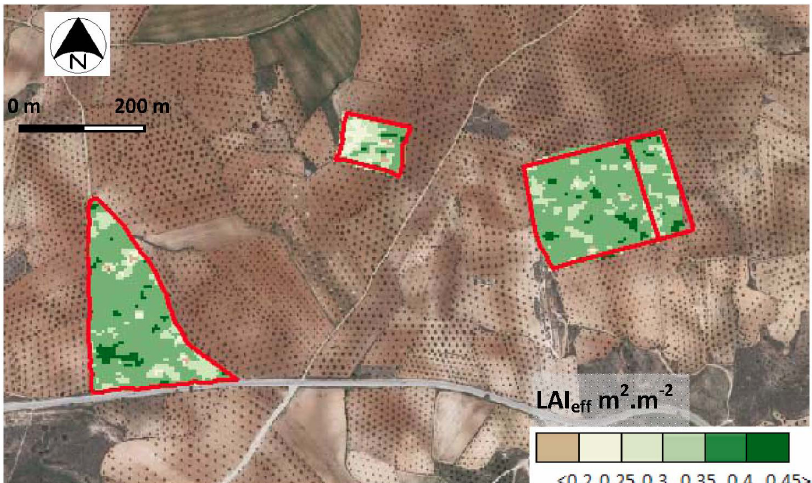
Figure 16. Effective LAI map derived by means of the proposed inversion